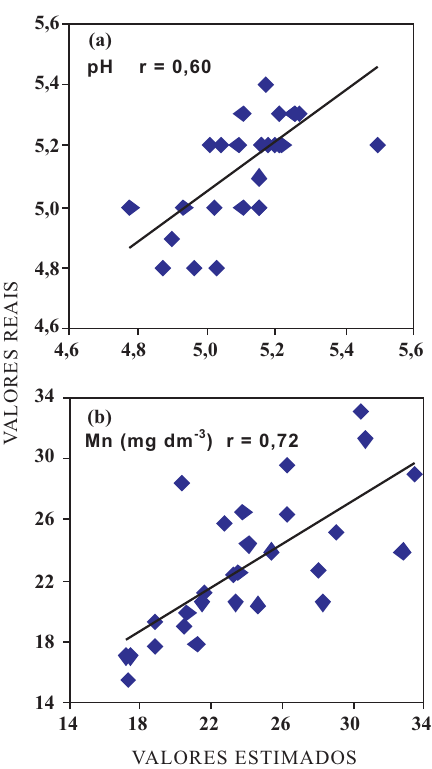
Figura 1. Biplots de valores reais vs estimados para: (a) pH e (b) Mn. Nota: análise efectuada com base nos dados apresentados no quadro 2 de Angelico (2006,